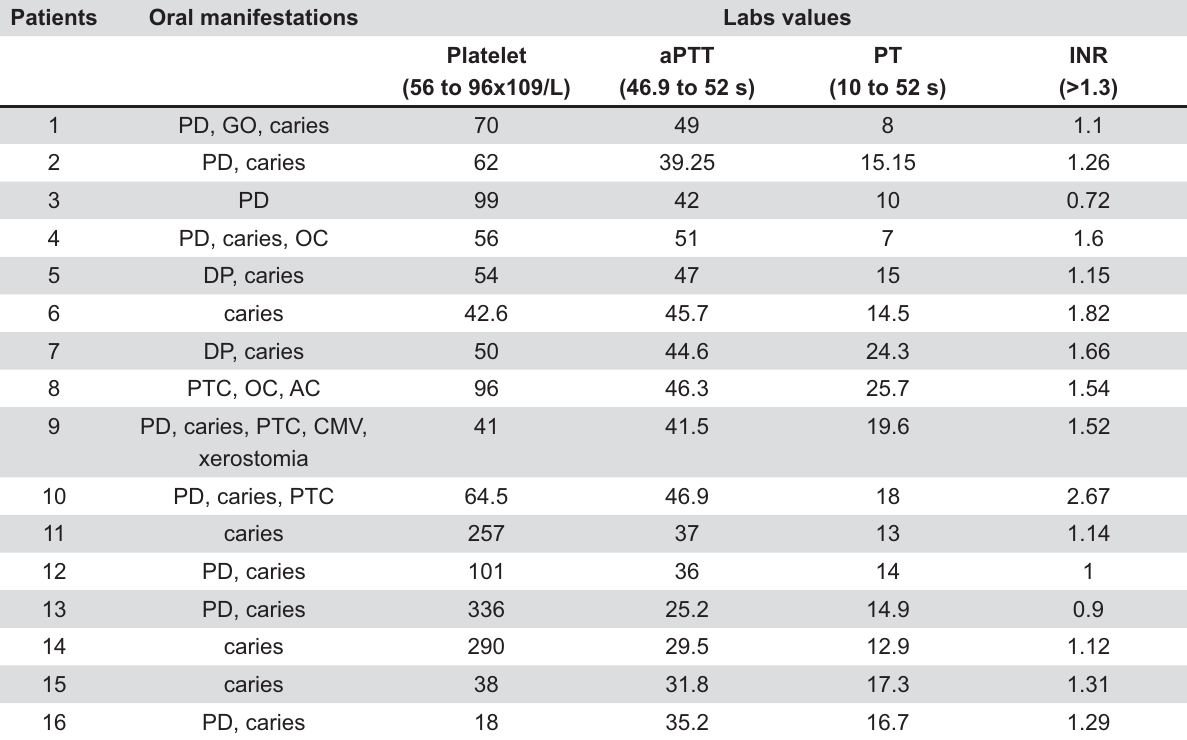
Table 1- Oral manifestations and coagulation